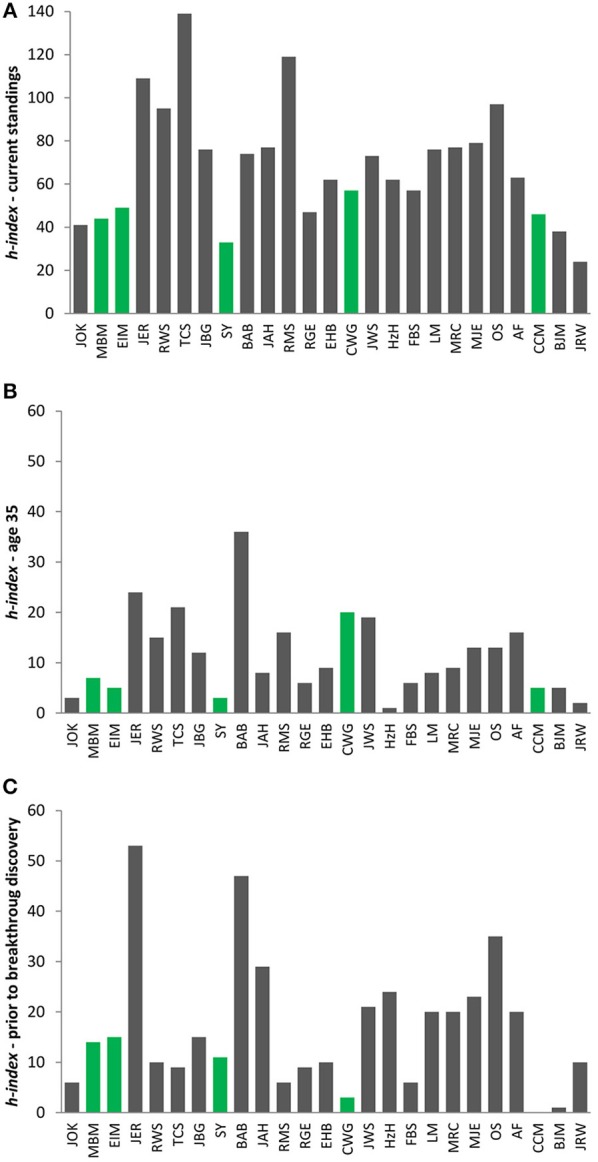
The h-indices of Nobel Prize laureates granted during the period 2005–2015; (A) current standings; (B) h-indices at the age of 35 years; (C) h-indices for the year prior to the breakthrough discovery. Green bars, Nobel Prize laureates born after 1960. Following papers were selected as the firstly announced breakthrough discovery of evaluated laureates: John O'Keefe, JOK (Morris et al., 1982); May-Britt Moser, MBM (Fyhn et al., 2004); Edvard I. Moser, EIM (Fyhn et al., 2004); James E. Rothman, JER (Söllner et al., 1993); Randy W. Schekman, RWS (Novick et al., 1980); Thomas C. Südhof, TCS (Südhof et al., 1987); John B. Gurdon, JBG (Gurdon et al., 1971); Shinya Yamanaka, SY (Takahashi and Yamanaka, 2006); Bruce A. Beutler, BAB (Poltorak et al., 1998); Jules A. Hoffmann, JAH (Lemaitre et al., 1996); Ralph M. Steinman, RMS (Steinman and Cohn, 1973); Robert G. Edwards, RGE (Edwards, 1965); Elizabeth H. Blackburn, EHB (Greider and Blackburn, 1985); Carol W. Greider, CWG (Harley et al., 1990); Jack W. Szostak, JWS (Lundblad and Szostak, 1989); Harald zur Hausen, HzH (Devilliers et al., 1987); Françoise Barré-Sinoussi, FBS (Barré-Sinoussi et al., 1983); Luc Montagnier, LM (Barré-Sinoussi et al., 1983); Mario R. Capecchi, MRC (Thomas and Capecchi, 1987); Sir Martin J. Evans, MJE (Evans and Kaufman, 1981); Oliver Smithies, OS (Blattner et al., 1977); Andrew Fire, AF (Fire et al., 1998); Craig C. Mello, CCM (Mello et al., 1991); Barry J. Marshall, BJM (Marshall and Warren, 1984); J. Robin Warren, JRW (Marshall and Warren, 1984). The h-indices of the examples provided were calculated according to the Web of Science Core Collection database (Thomson Reuters).